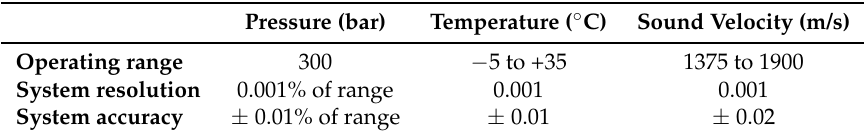
Table 2. The Valeport UV-SVP sensor technical